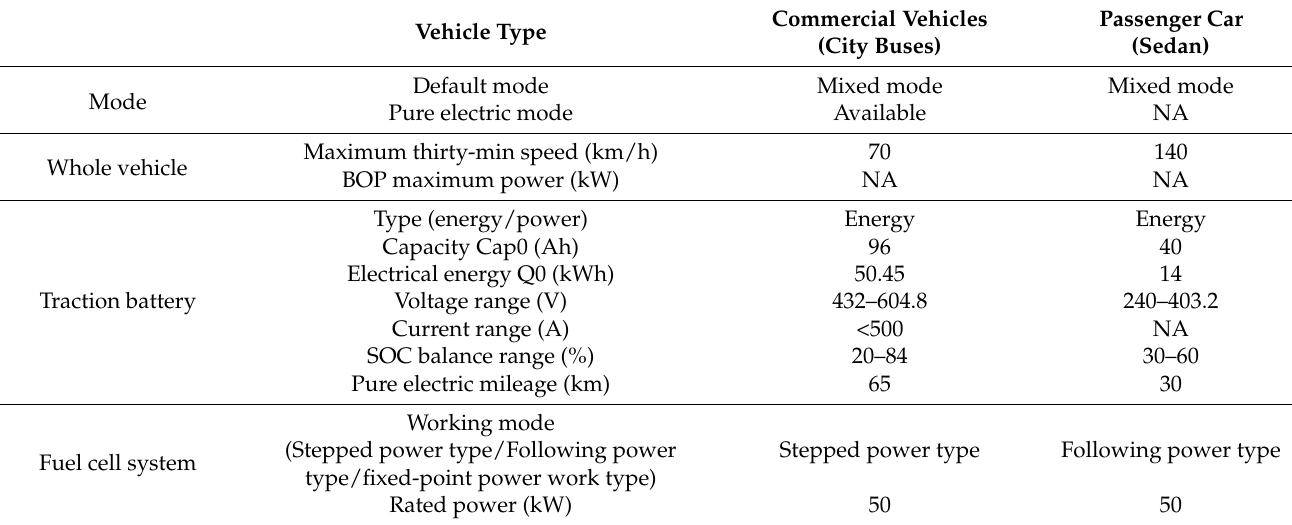
Table 1. Test vehicle